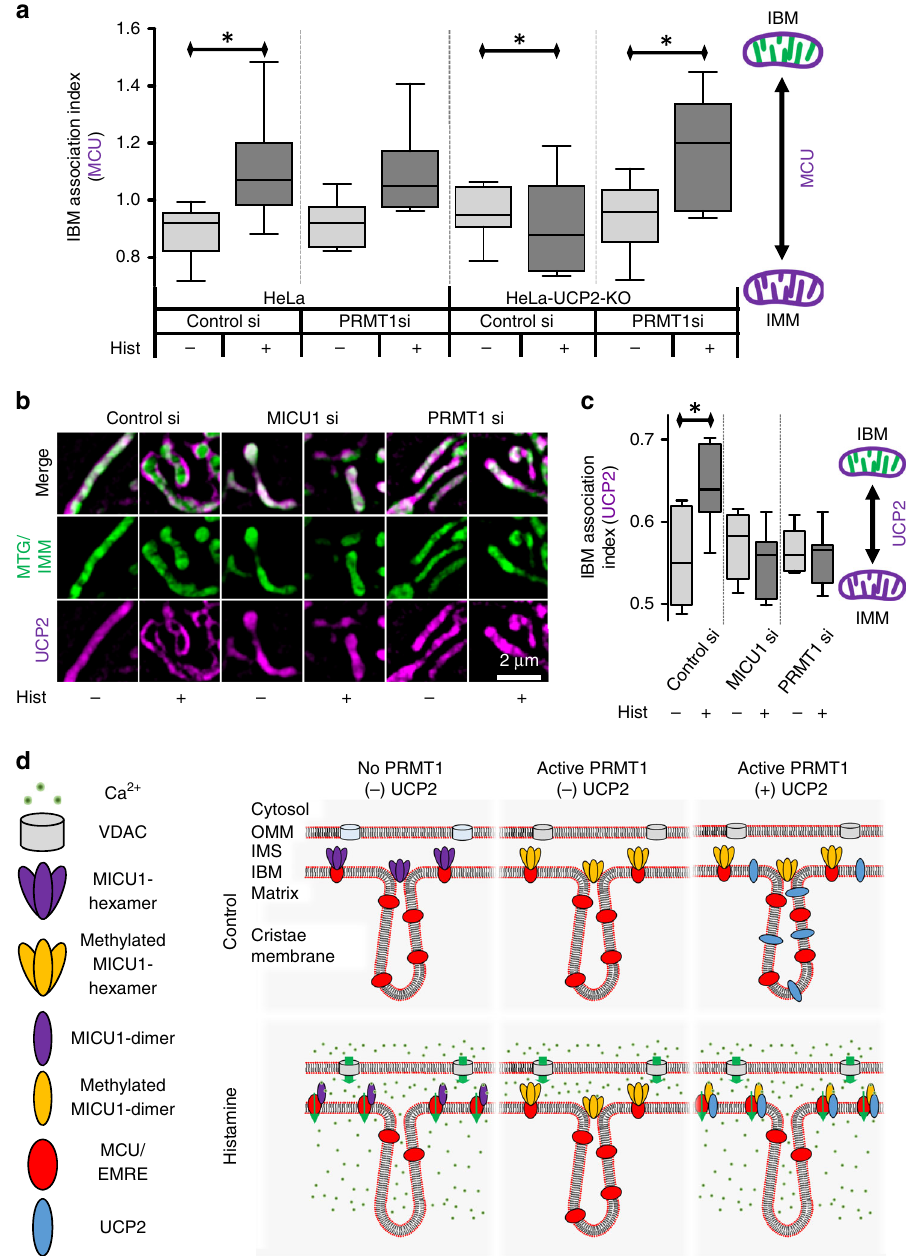
Fig. 8 Under elevated PRMT1 activity, UCP2 is essential for MCU IBM relocation. a Statistical analyses of sub-mitochondrial localization of MCU-mCherry were performed on control ( HeLa ) and UCP2 − / − ( HeLa-UCP2-KO ) cells with and without PRMT1 knockdown under resting conditions and 90 s after stimulation with 100 µ M histamine ( n = 8). b Representative SIM images of cells expressing UCP2-mCherry (magenta) and stained with MTG (green) in the presence ( Control si ) or absence of endogenous MICU1 ( MICU1 si ) or PRMT1 ( PRMT1 si ) under resting conditions ( − ) and 90 s after stimulation with 100 µ M histamine ( + ). c Analysis of the sub-mitochondrial localization of UCP2 during the experiments described in b ( n = 8). d Model for the sub- mitochondrial localization of MICU1, and localization and assembly of the MCU-Complex under resting conditions ( Control ) and upon IP 3 -mediated intracellular Ca 2 + release ( Histamine ) in cells with low PRMT1 activity (left), in cells with active PRMT1 lacking UCP2 (middle), and in cells with active PRMT1 and in the presence of UCP2 (right). In the absence of PRMT1 activity, Ca 2 + spikes in the intermembrane space restructure MICU1 hexamers into dimers in the IBM, where they act as diffusion traps for MCU. These molecules can now anchor EMRE in the IBM, thus assembling MCU-Complexes there. In the absence of UCP2, PRMT1 prevents the reorganization of MICU1 into dimers upon intracellular Ca 2 + release, thus no shuttling of MCU (nor EMRE) to the IBM takes place and no functional MCU-Complexes are assembled. However, the presence of UCP2 allows the dimerization of MICU1 even in the presence of elevated PRMT1 activity, and thus restores the diffusion trap capabilities of MICU1 by either stabilizing the methylated MICU1 dimer or preventing the methylated MICU1 oligomer from disrupting it. Consequently, the MCU-Complex is assembled and mitochondrial Ca 2 + uptake is restored. Analyses were obtained from at least 5 cells each in 8 experiments. Horizontal lines represent the median, the lower and upper hinge show respectively fi rst quartile and third quartile, and lower and upper whisker encompass minimal and maximal values. * P < 0.05 vs. respective control conditions carried out with unpaired double-sided T -test. Source data are provided as a Source Data fi